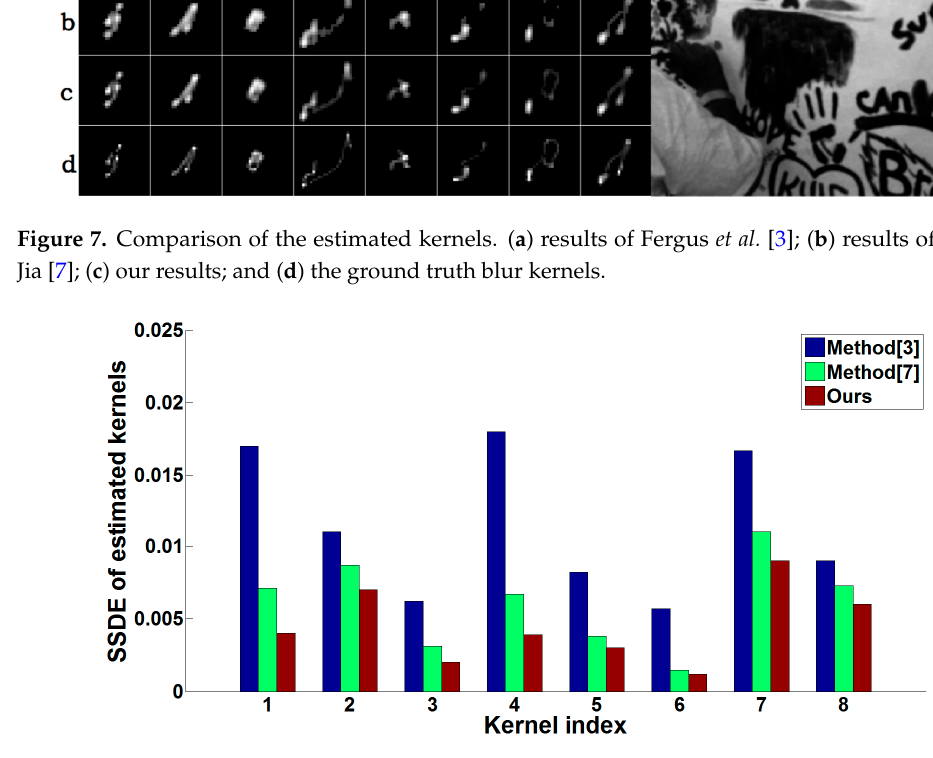
Figure 8. Comparison of the estimated kernels in terms of SSDE.